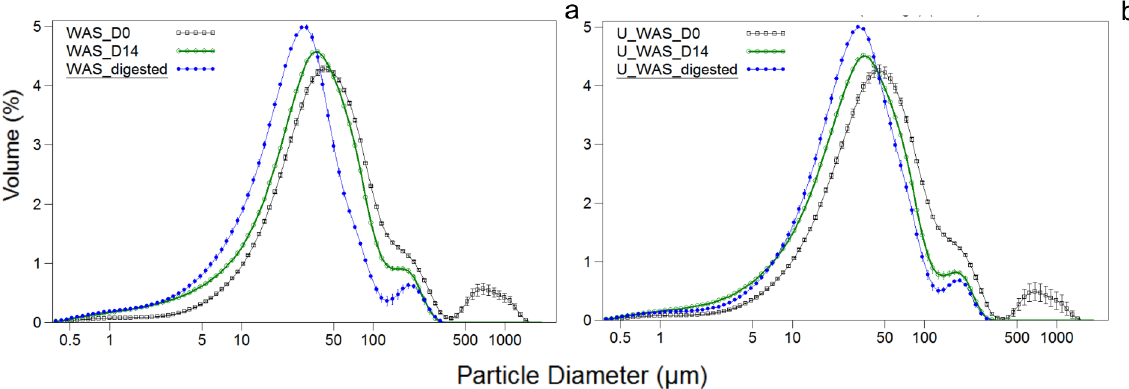
Figure 2. Particle size distribution (PSD) obtained from samples taken from batch